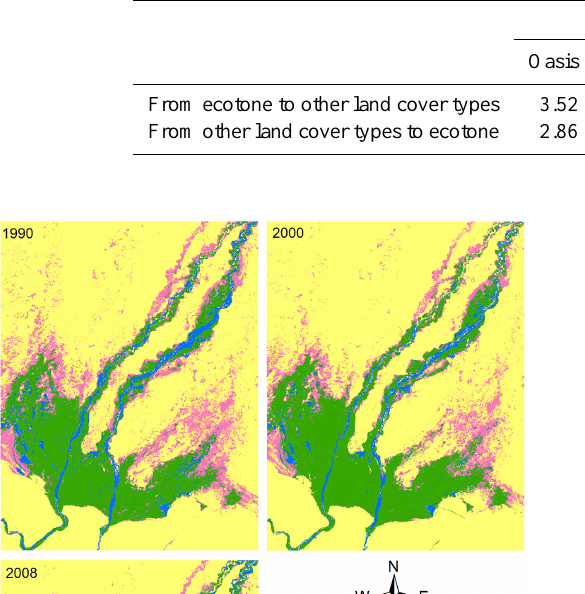
Table 6. The average annual transition probabilities between ecotone and other land cover types (units: %).